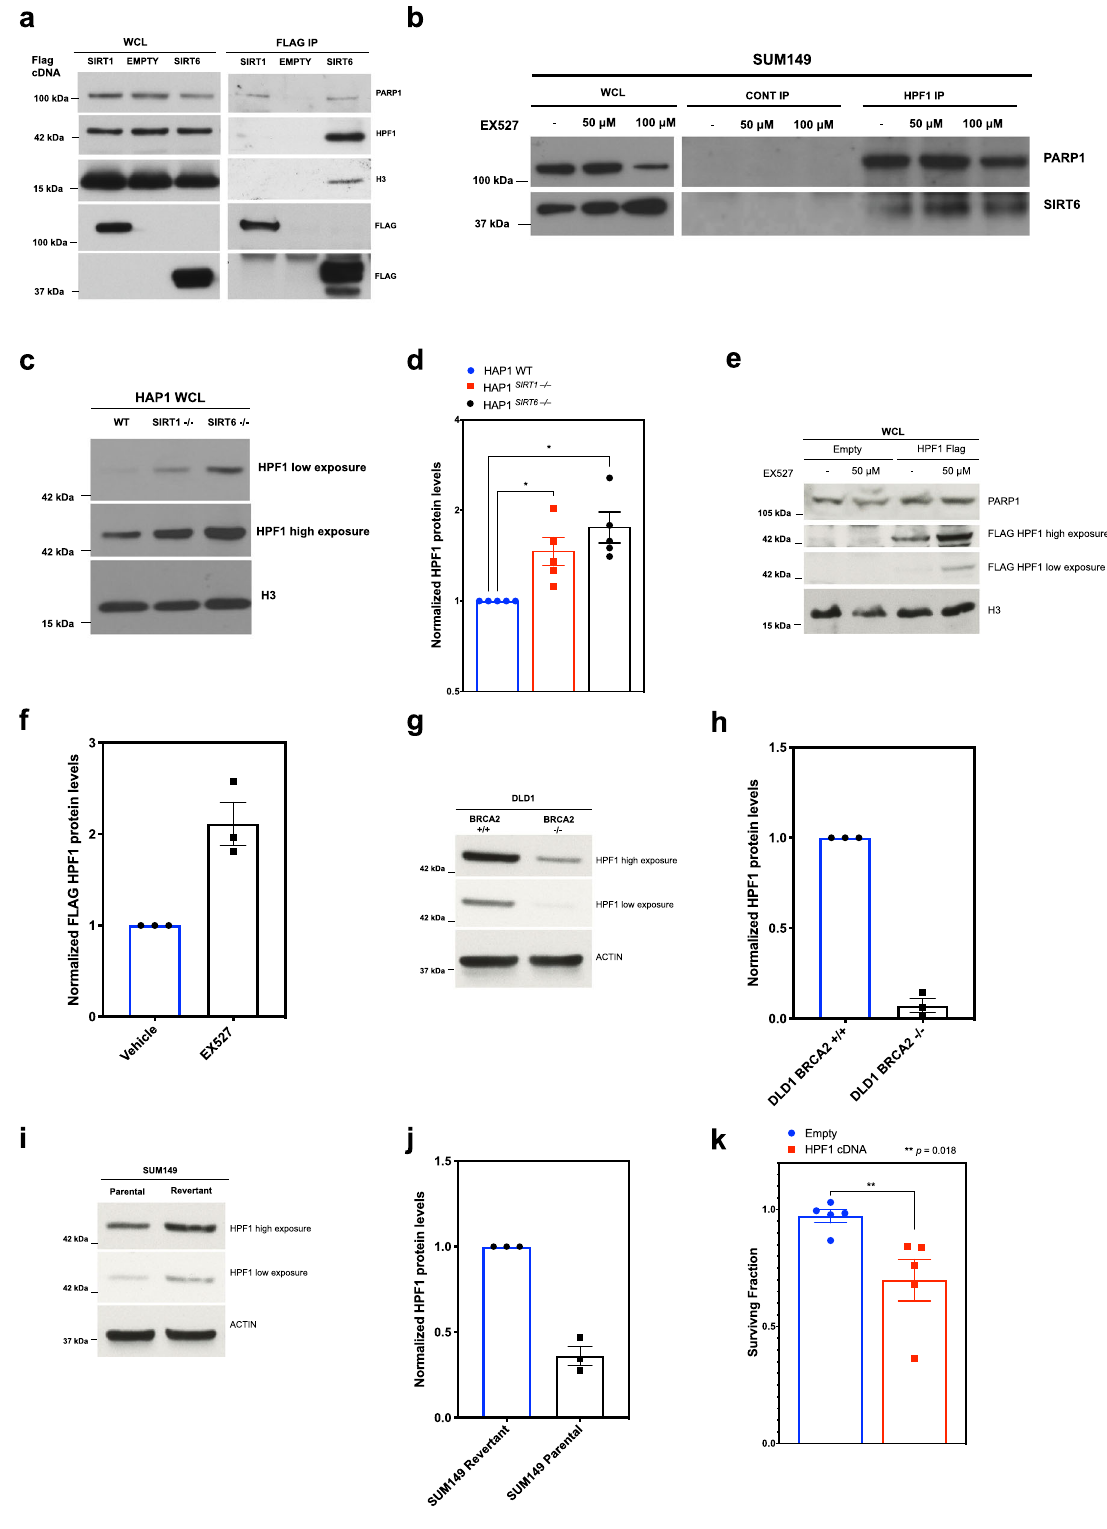
Cell survival assays . Cell survival assays were performed in 96 ‐ well plates. For measurement of sensitivity to EX527 and Salermide, cells were seeded in 96 ‐ well plates at a concentration of 200 – 750 cells per well. Twenty ‐ four hours post ‐ seeding, drug treatment was initiated and cells were continuously exposed to the drug with media. After 7 days, cell viability was estimated using CellTiter-Glo (Promega). SFs were calculated and drug sensitivity curves plotted as previously described 70 .